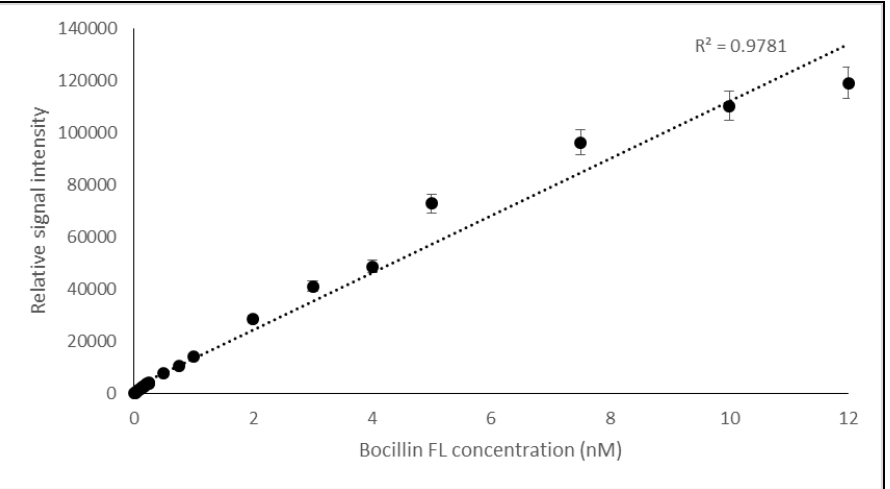
Figure 2. Calibration curve of the Bocillin FL fluorescence intensity using concentrations varying from 0–12 nM of the compound while using a real-time PCR machine for reading (at wavelengths of 511 nm for emission and 504 nm for excitation), which shows the collinearity between concentration and signal intensity (R 2 = 0.9781).